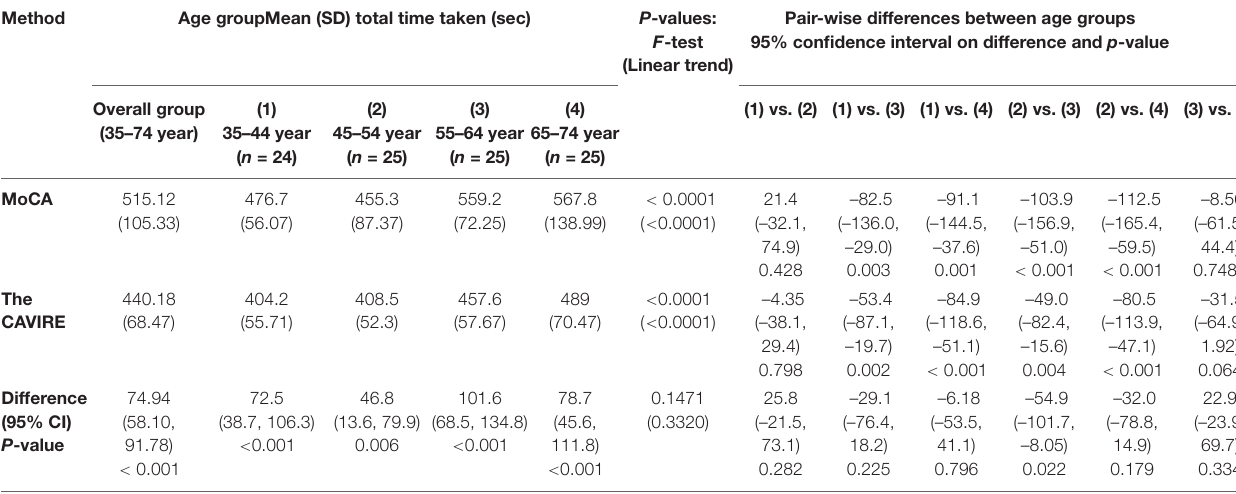
TABLE 2 | Total time taken (SD) for MoCA and the CAVIRE tasks by age group with differences and 95% confidence intervals. Method